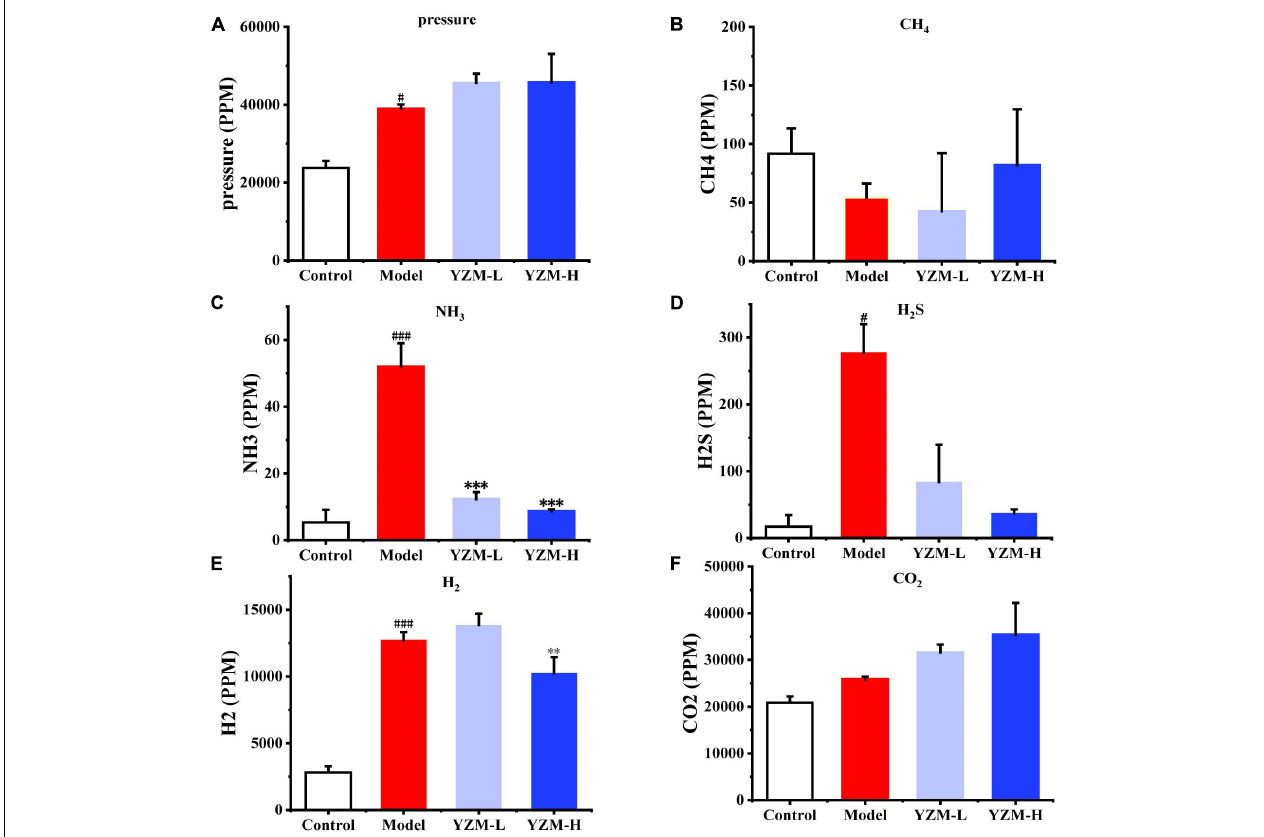
FIGURE 2 | Gas produced by intestinal microbiota. (A) The pressure after fermentation. (B–F) The abundance of CH 4 , NH 3 , H 2 S, H 2 , and CO 2 , respectively. ### p < 0.001 vs control, # p < 0.05 vs control; *** p < 0.001 vs model, ** p < 0.01 vs model.